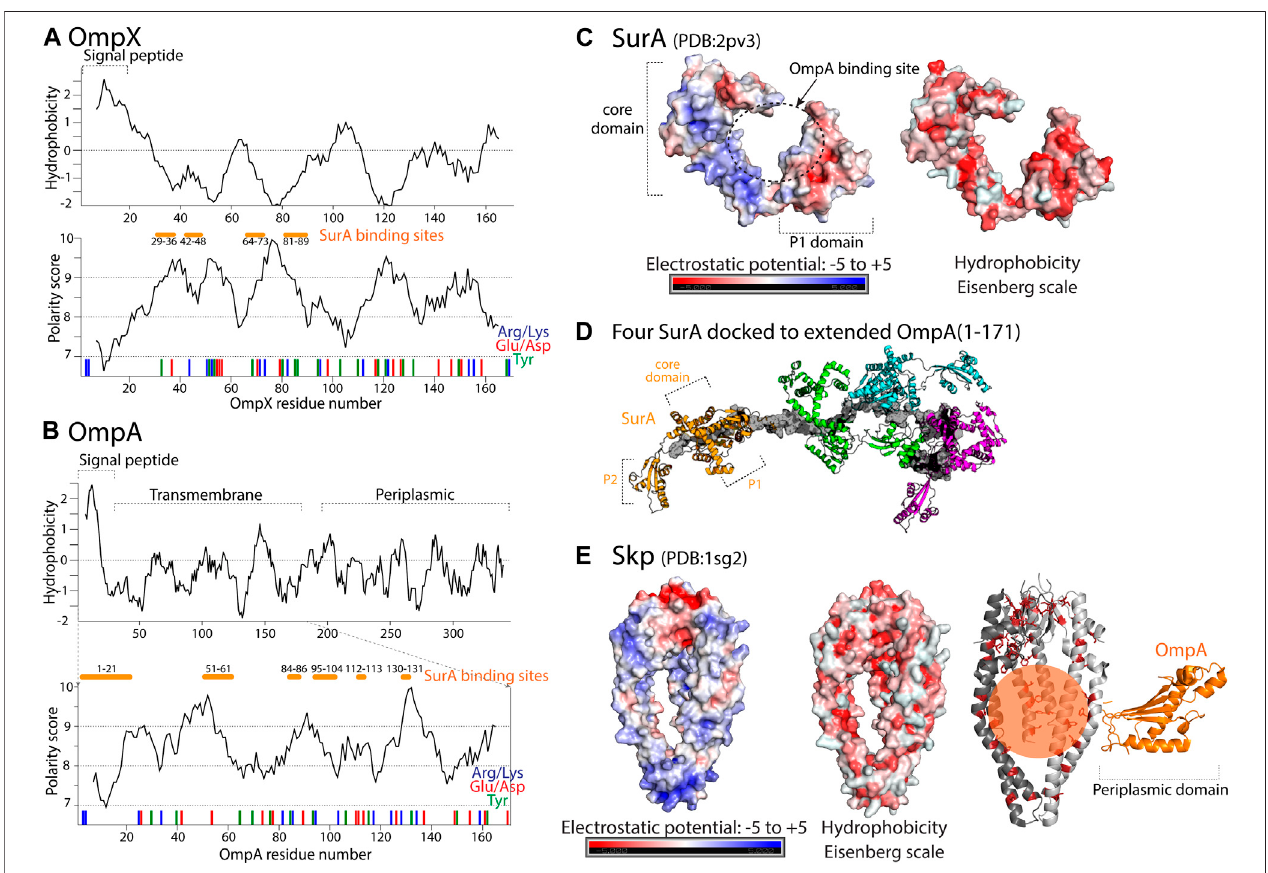
FIGURE 4 | Properties of periplasmic chaperones SurA and Skp and their selected client proteins. (A) Hydrophobicity prediction of the full length OmpX client protein based on Kyte-Doolittle hydrophobicity scale is shown in the upper plot. Polarity prediction based on Grantham scale, performed with Expasy, is shown in the lower plot as a function of OmpX residue number. In red and blue bars, position of negatively and positively charged residues is shown. Position of tyrosine residues is shownwithgreenbarsandproposedbindingsitetoSurAMarxetal.(2020b)isshownwithorangebars. (B) Upperplotshowshydrophobicitypredictionofthefull- length OmpA client protein. In the lower plot polarity prediction for residues 1 – 171 of OmpA is shown based on Grantham scale. In red and blue bars, position of negatively and positively charged residues is shown. Position of tyrosine residues is shown with green bars, as they are proposed to be involved in the binding to SurA Marx et al. (2020b). (C) Electrostatic potential and hydrophobicity (Eisenberg scale) plotted onto the core and P1 domains of SurA [in the open/bound conformation Xu et al. (2007)]. (D) Model of the SurA-OmpA (1 – 171) complex with four full-length SurA (colored molecules) docked to expanded OmpA (shown in gray). Figure adapted from Marx et al. (2020b). (E) Electrostatic potential and hydrophobicity (Eisenberg scale) plotted on the surface of the Skp chaperone. On the right, representation of OmpA-Skpcomplexwhiththeclientproteinshowninorange.TheperiplasmicdomainofOmpAisproposedtobefoldedandnotboundtoSkpwhilethe β -bareldomain remains unfolded in the Skp binding cleft Walton et al. (2009). The whole transmembrane part of OmpA is bound within the Skp tentacles through multiple electrostatic and hydrophobic interactions Qu et al. (2009). In the complex, hydrophobic residues of Skp are shown as sticks colored in